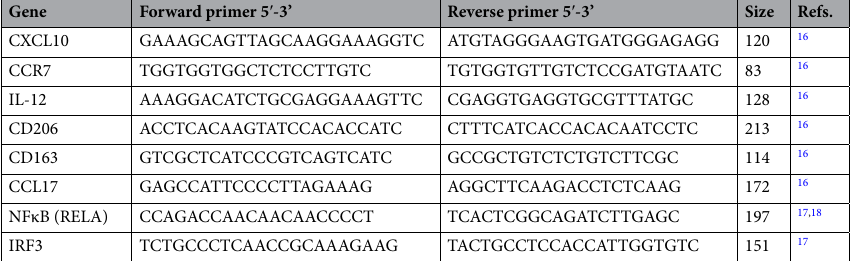
Table 1. qPCR genes of interest, sense and antisense primer sequence and amplicon